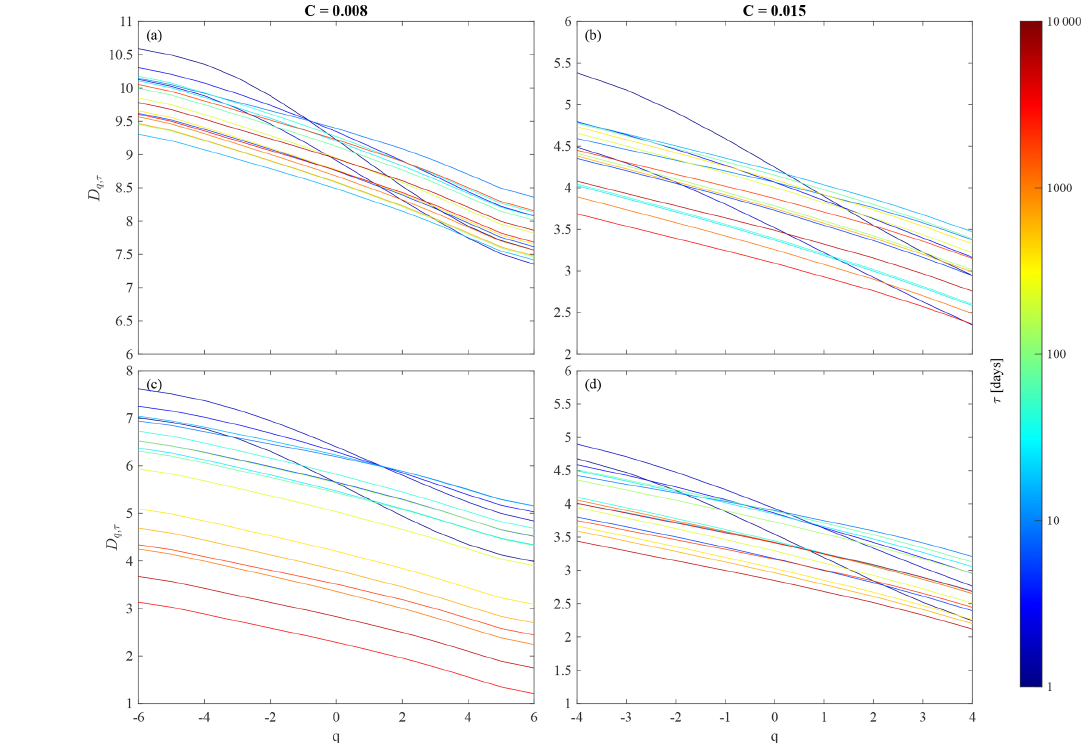
Figure 11. D q,τ spectra for the dynamics of atmosphere and ocean individually at different timescales τ j (indicated by different line colors) for reconstructions of MIMFs as in Eq. (12) ( D q,τ ) for (a, c) C = 0 . 008 and (b, d) C = 0 . 015. Panels (a, b) refer to the atmosphere, (c, d) to the